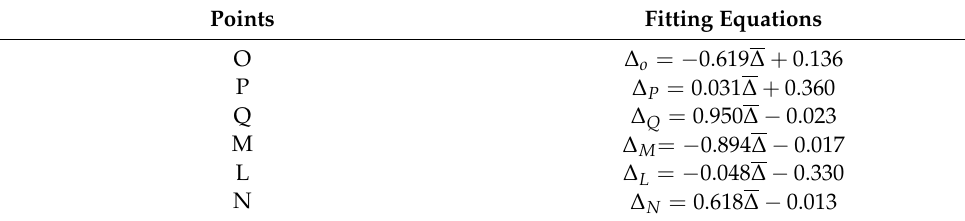
Table 8. Fitting equations of points M, L, N, O, Pand